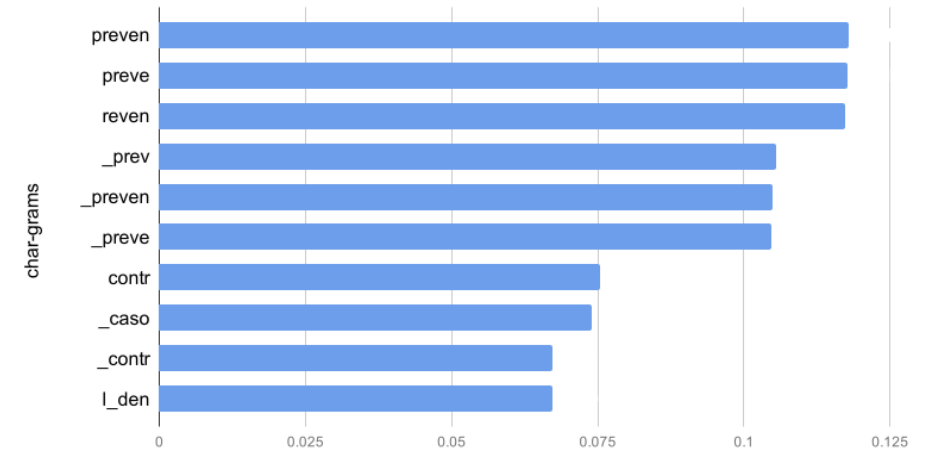
Figure 15. Information gain for the best five-, six-, seven- and